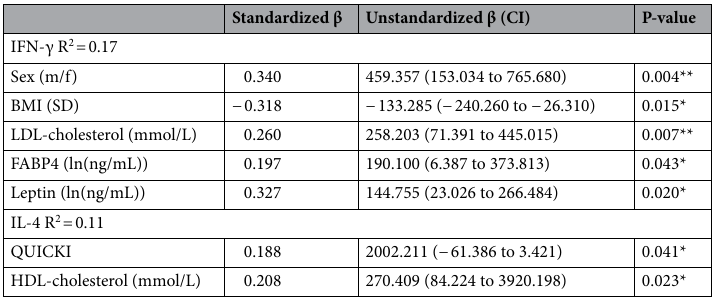
Table 2. Multivariable linear regression identifies immunometabolic predictors. Multiple linear regression analysis of plasma-induced iNKT cell IFN-γ and IL-4 (n = 114) production in co-culture. Variables entered for backwards selection: Sex, BMI (SD), WHR, fasting glucose, QUICKI, LDL-cholesterol, HDL-cholesterol, triglycerides, hs-CRP, lymphocyte count, monocyte count, FABP4, adiponectin, leptin, chemerin, MCP-1, Cathepsin S. WHR, fasting glucose, triglycerides, hs-CRP, monocyte count, FABP4, leptin, and MCP-1 were first log-transformed. Only significant predictors were reported. * p < 0.05, ** p <